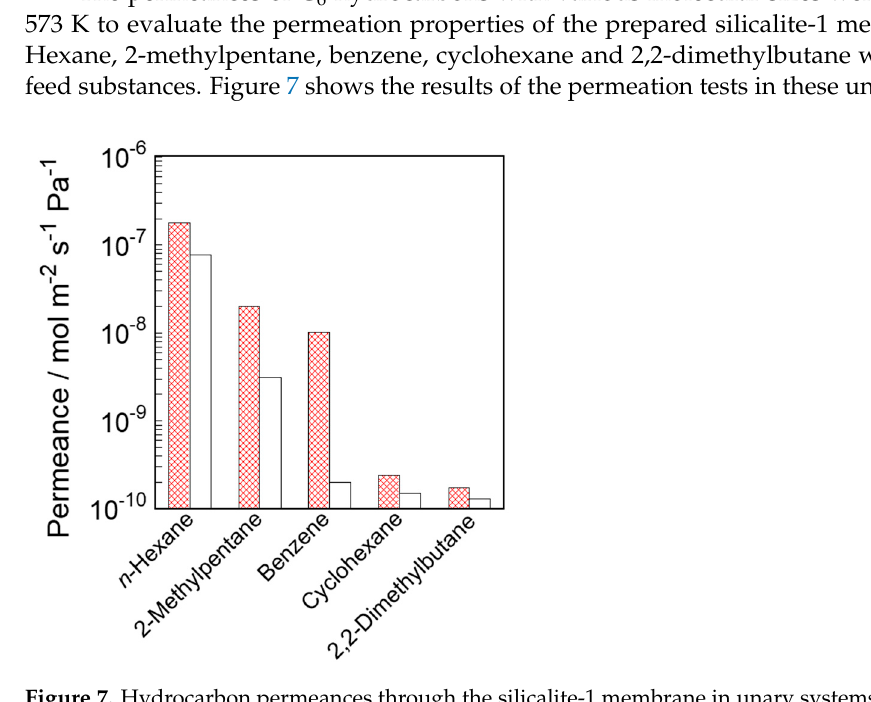
Figure 7. Hydrocarbon permeances through the silicalite-1 membrane in unary systems. Shaded and open bars correspond to S-1 S and S-1 M , respectively.